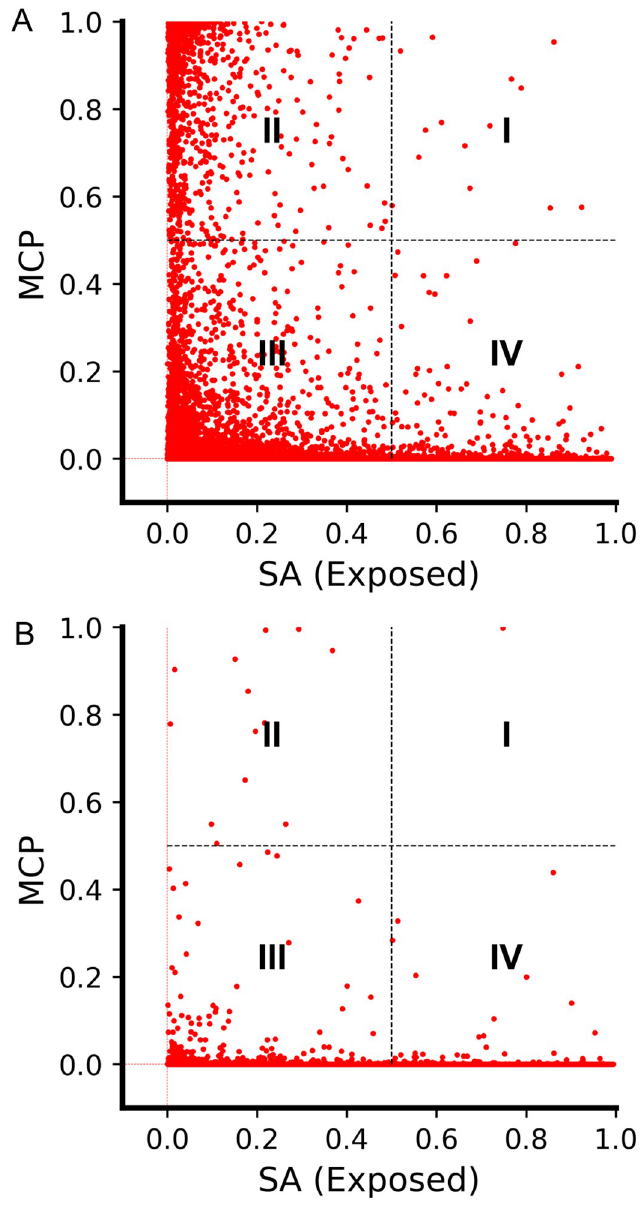
Fig 3. The 2D plot of the complementary MCP and SA predicting the likely location of amino acids in a protein, for the 327-protein dataset (A) and 102 Pfam protein dataset (B), respectively. The figures are roughly divided into four regions: (I) Both the MCP and SA values are larger than 0.5, indicating the amino acids in this region are likely to be exposed to both water and lipid molecules; (II) MCP > 0.5 and SA < 0.5, meaning the amino acids in this region are more likely to be exposed to hydrophobic lipid molecules than to water molecules; (III) MCP < 0.5 and SA < 0.5, meaning the amino acids are not likely to be exposed to either lipid or water molecules, so they are probably embedded in the interior of proteins; and (IV) MCP < 0.5 and SA > 0.5, meaning the amino acids are more likely to be exposed to water molecules than to the lipid bilayer.